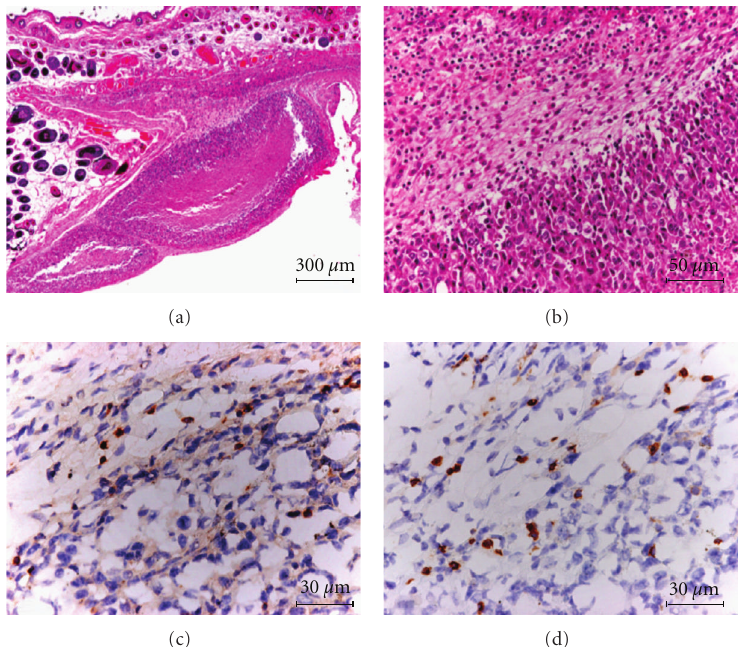
Figure 8: Histopathology and immunohistochemistry of a re-challenge tumor. (a) A low-power view of a re-challenge tumor with HE staining ( × 49). (b) A high-power view ( × 200). Monocytic infiltrates are seen around a necrotic lesion. (c) CD4 + T cells ( × 400). (d) CD8 + T cells ( × 400). Almost equal numbers of CD4 + and CD8 + T cells are